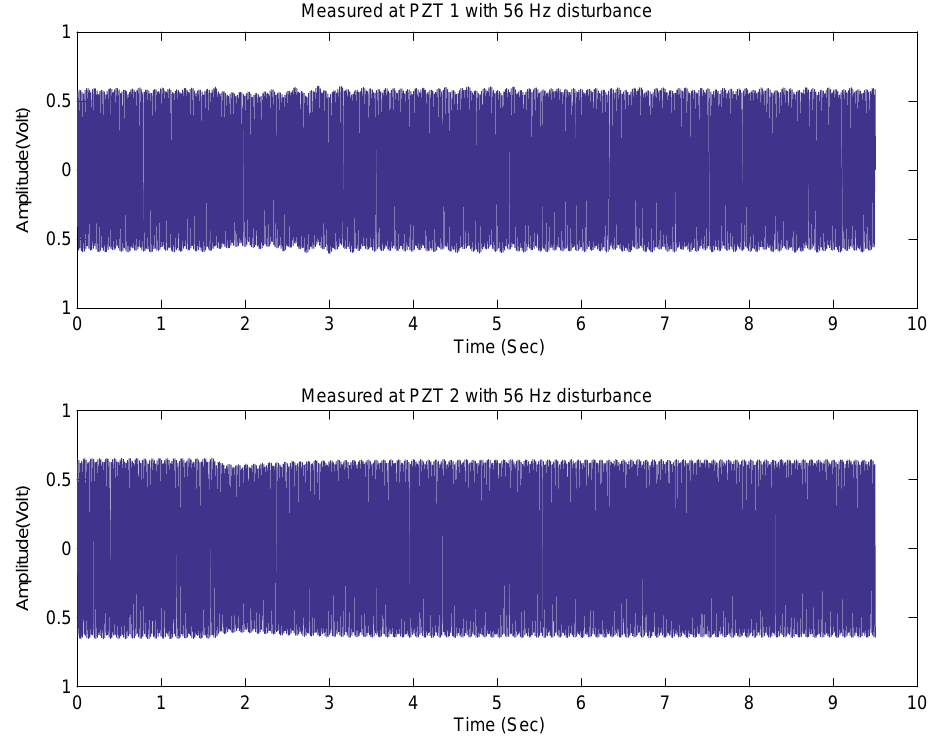
Fig. 10. Vibration suppression with 56 Hz sinusoidal disturbance using Luenburger